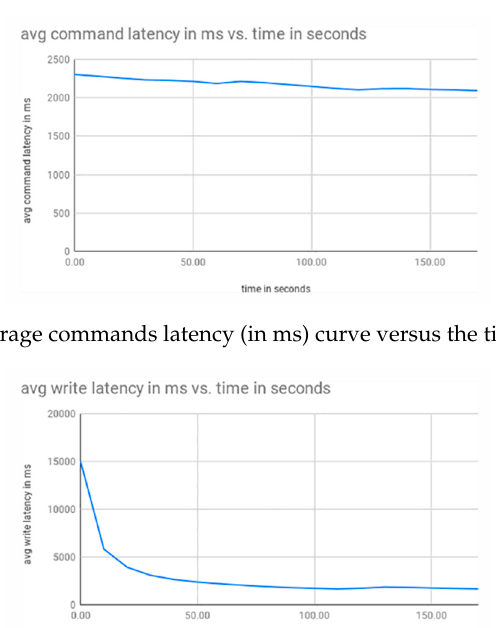
Figure 18. Average writes latency (in ms) curve versus the time in seconds.